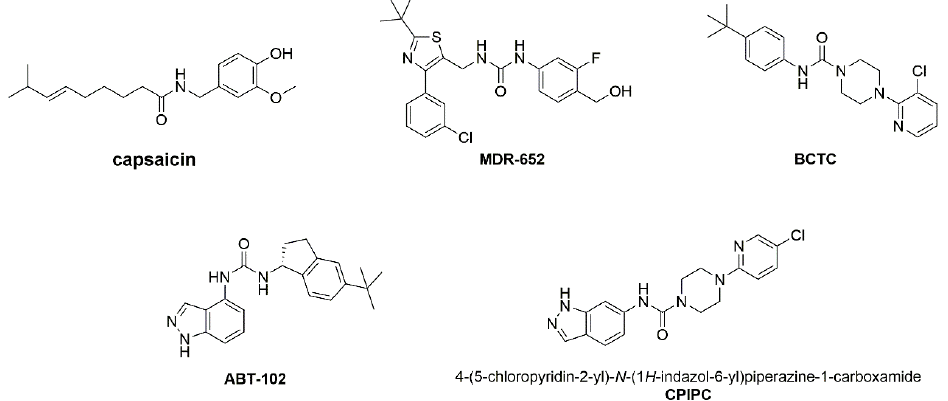
Figure 1. The chemical structures of TRPV1 modulators of capsaicin, MDR-652, BCTC, ABT-102 and CPIPC .